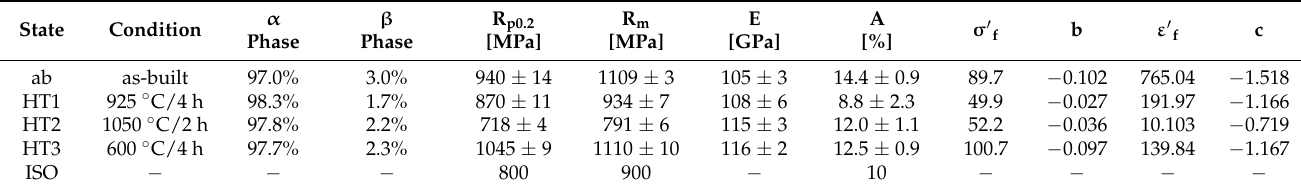
Figure 6. XRD patterns of as-built and heat-treated Ti-6Al-7Nb samples. Table 1. Phase fraction detected by means of EBSD and results of quasi-static and fatigue tests of the LPBF fabricated, as-built, and heat-treated Ti-6Al-7Nb, including the minimum values regarding standard ISO 5832-11